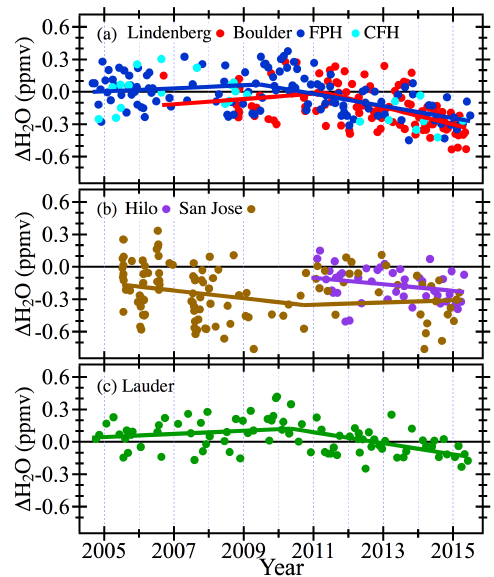
Figure 2. Differences between FP mixing ratios and spatiotempo- rally coincident MLS v3.3 water vapor retrievals at 68hPa over the five FP sounding sites. In the top panel (a) dark blue and cyan mark- ers for Boulder depict soundings made with the NOAA FPH and the CFH, respectively. Lines show the trends in FPH–MLS differences in two distinct periods separated by a changepoint, except for Hilo where the shorter FP records show no indications of statistically significant